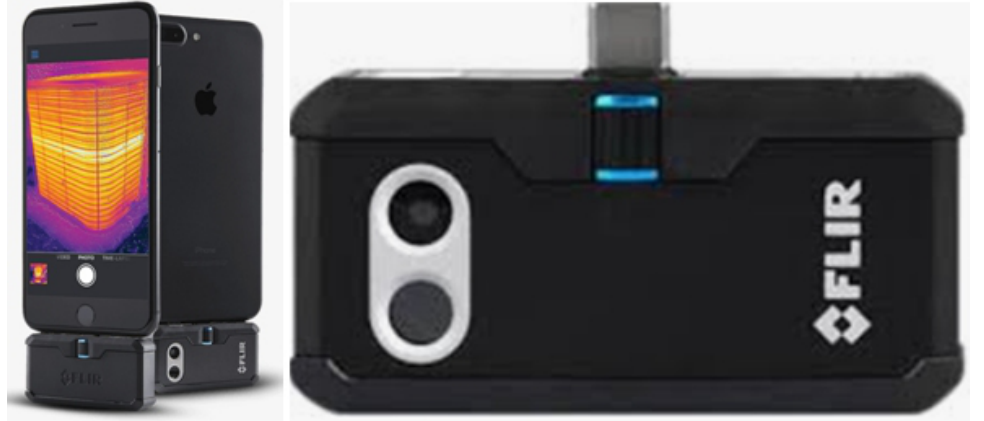
Figure 1. FLIR One camera and connection to a smartphone